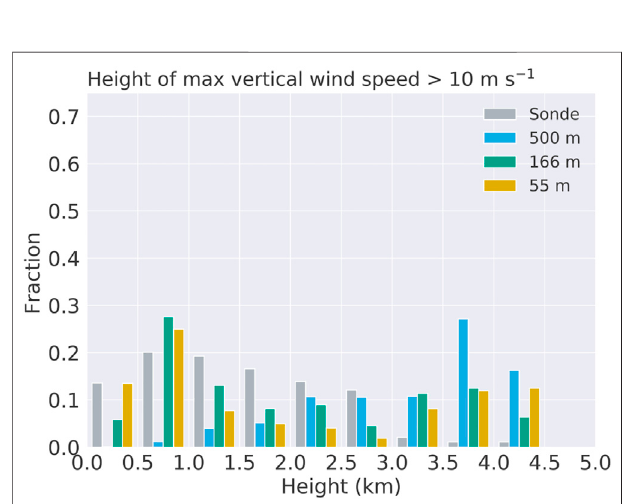
FIGURE 15 | PDFs for height of maximum vertical velocity greater than 10 m s − 1 at t (cid:2) 9 h of the simulation. Sonde represent observed dropsondes from Stern et al. (2016) and Stern and Bryan